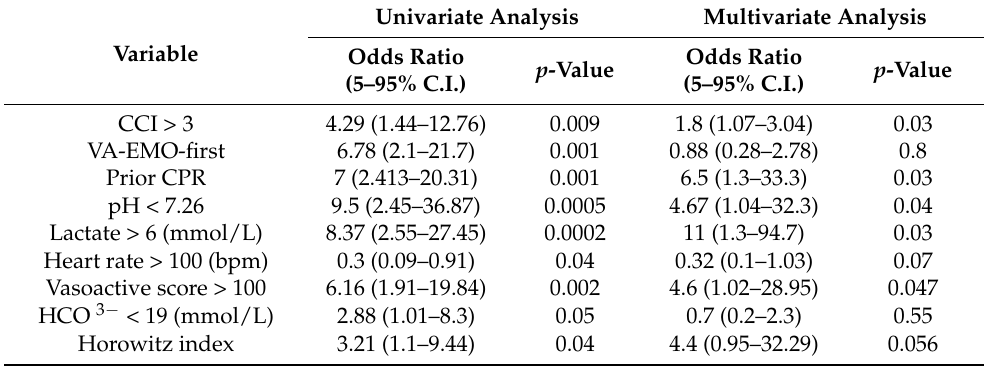
Table 3. Univariate and multivariate analysis of risk factors associated with mortality.